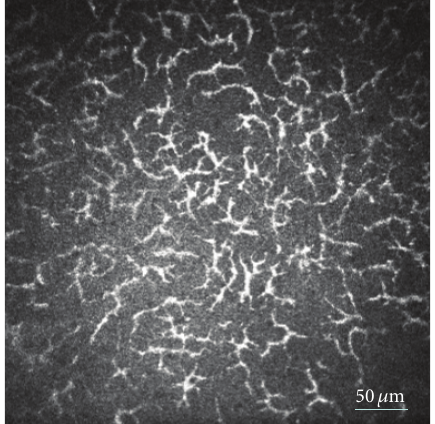
Figure 2: In vivo confocal microscopic image of corneal dendritic (Langerhans) cells (LC). Original size of the image is 400 𝜇 m × 400 𝜇 m. Bar indicates 50 𝜇 m. Network of activated LCs with dendrites in an extreme large density in the central cornea of an SLE patient (depth of image from surface 41 𝜇